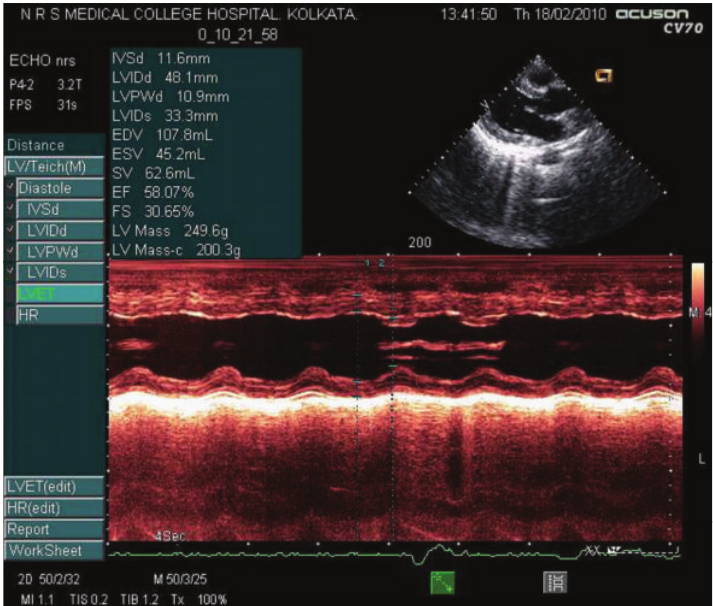
Figure 3: Posttreatment echocardiography showing marked improvement of left ventricular systolic